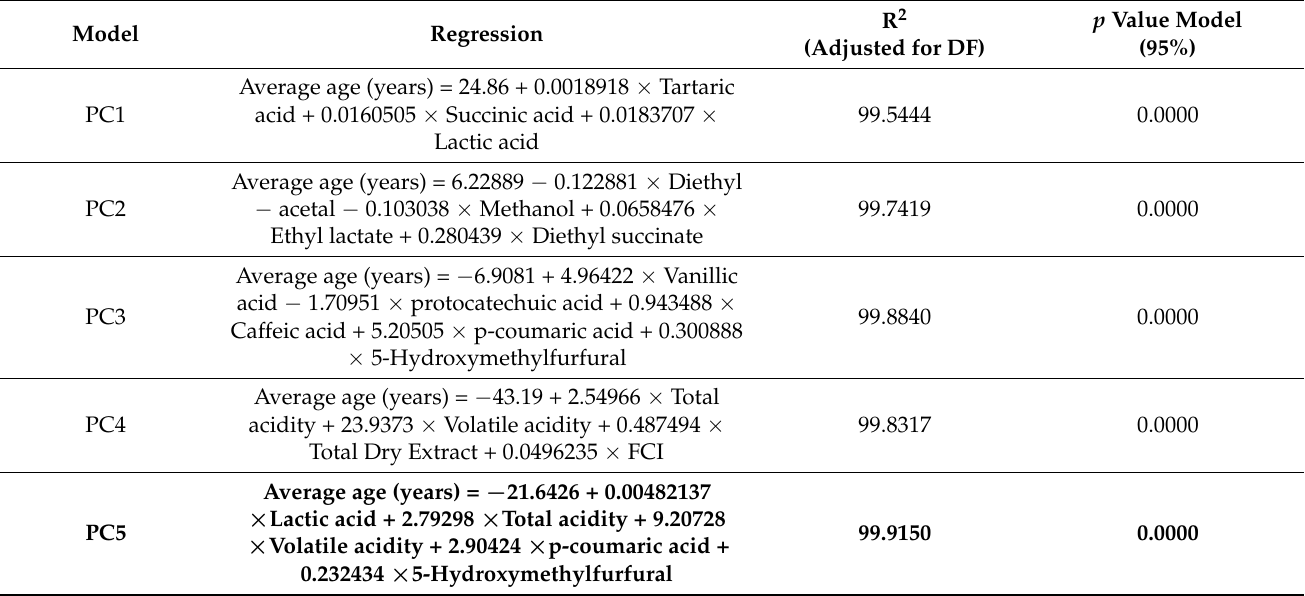
Table 13. Regression models (MLR) to estimate the ageing of Palo Cortado Sherry wines. PC1: glycerol and organic acids; PC2: polyphenols model; PC3: volatile compounds model; PC4: “other variables” model; PC5: overall